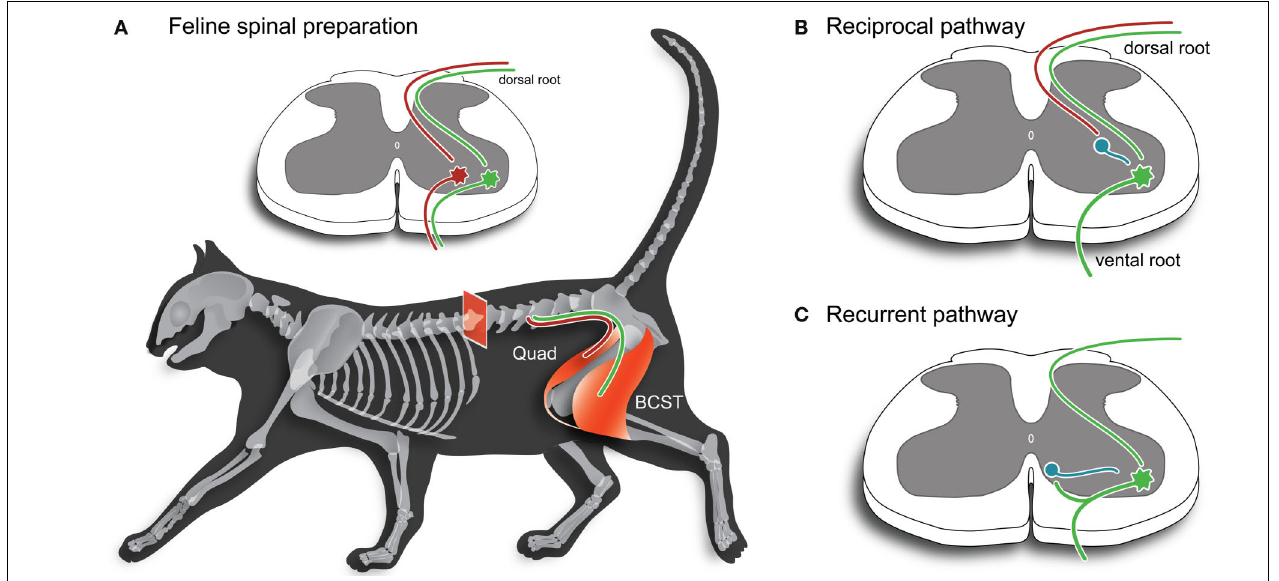
FIGURE 1 | Key spinal cord motor pathways used to study synaptic mechanisms in the mammalian CNS. (A) Schematic illustrating two hind limb muscles employed extensively in the study of spinal cord refl exes and synaptic transmission in the 1950s and 1960s. The quadriceps (Quad) and biceps- semitendonosus (BCST) muscles produce extension and fl exion about the knee joint, respectively. Inset, shows a spinal cord cross-section and the monosynaptic excitatory pathway. Afferents originating in annul spiral endings of muscle spindles (1a afferents) are involved in the classic stretch refl ex, which is used clinically to test the integrity of spinal circuits. These afferents (red and green axons) make monosynaptic connections with motoneurons that innervate the same (homonymous) muscle. (B) Inhibition is produced in motoneurons by activation